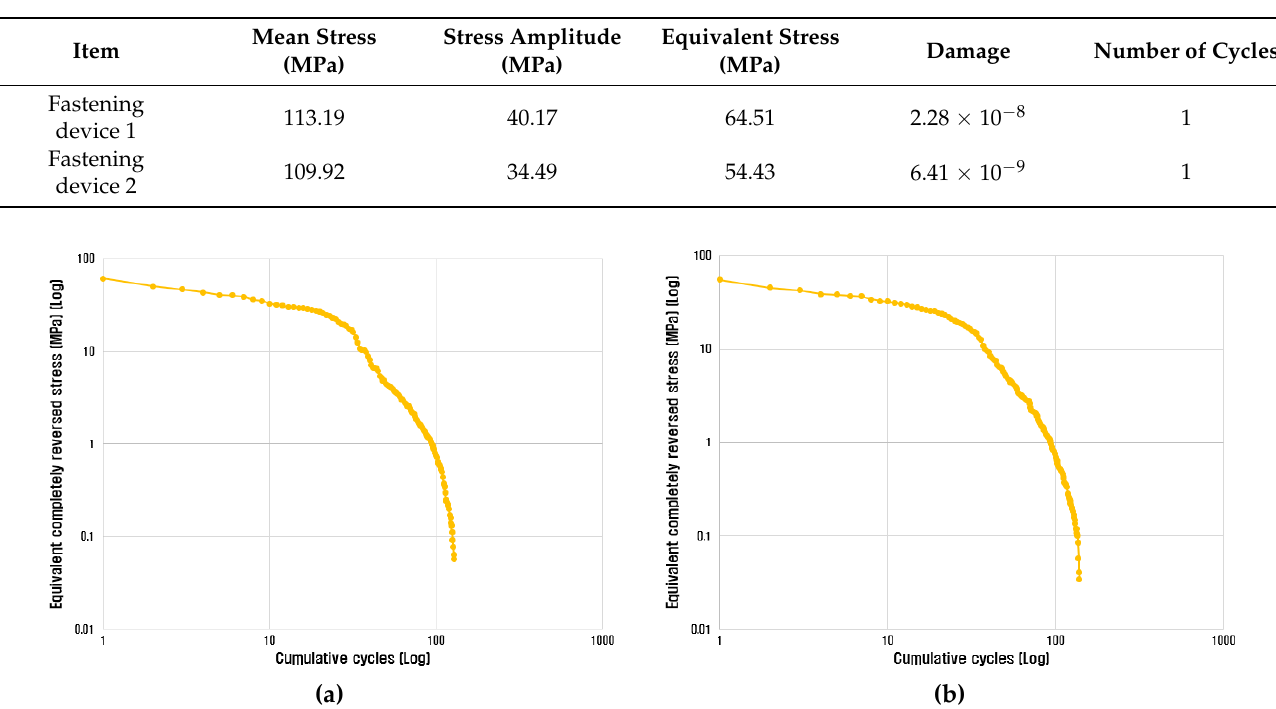
Table 6. Maximum damage condition at each fastening device when loading part is not lifted.